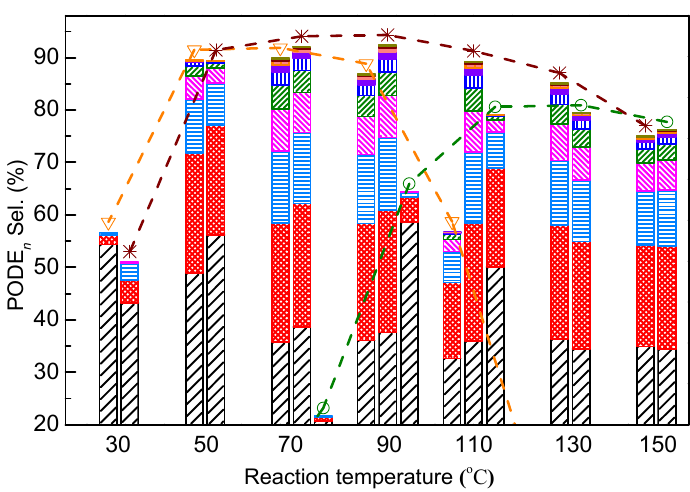
Figure 4. The PODE n product distribution over ZSM-5 and USY. : ZSM-5 (Si/Al = 17), : ZSM-5 (Si/Al = 267), : USY (Si/Al = 10), black bar: PODE 2 , red bar: PODE 3 , sky-blue bar: PODE 4 , magenta bar: PODE 5 , olive bar: PODE 6 , blue bar: PODE 7 , violet bar: PODE 8 , orange bar: PODE 9 , wine bar: PODE 10 , dark yellow bar: PODE 11 .